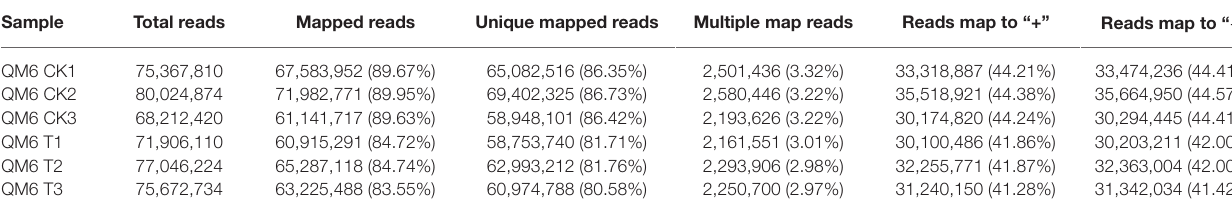
TABLE 2 | Summary of high throughput transcriptome sequencing of QM6 under two